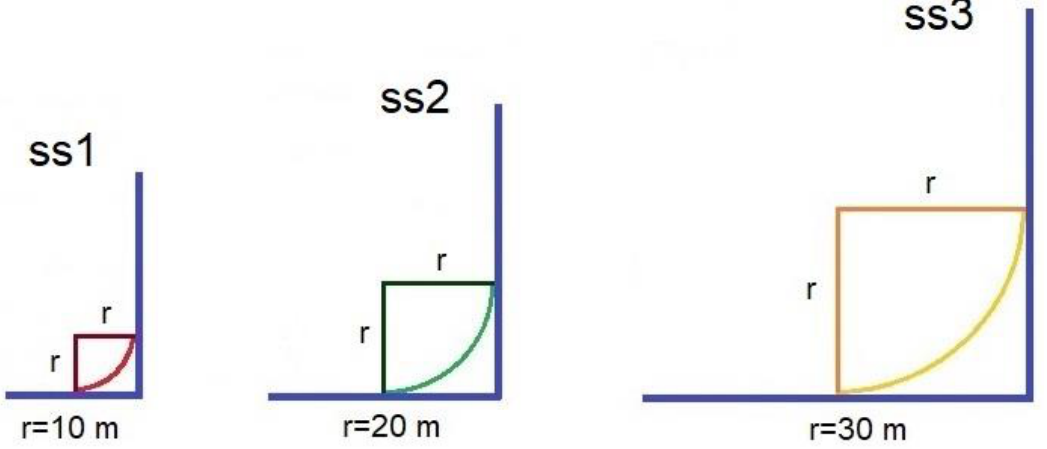
Figure 1. Smoothing steps achieved by inscribing the quadrant into the corner of the cavern’s vertical cross section: ss1—smoothing step 1, ss2—smoothing step 2, ss3—smoothing step 3. Table 1. Shapes and dimensions of simulated salt caverns.